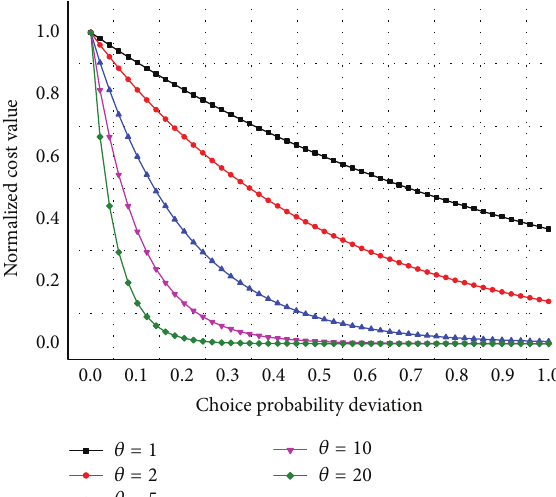
Figure 6: Path choice probability deviation with different values of 𝜃 .